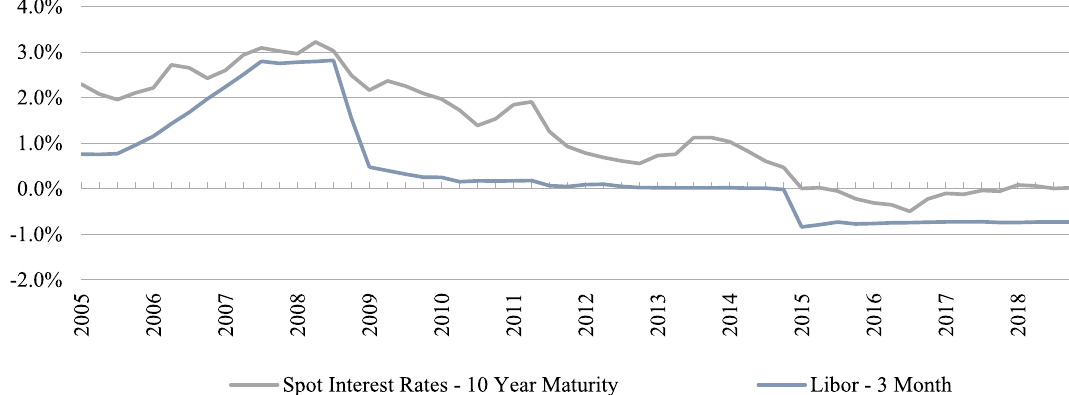
Fig. 2 Spot interest rates and Libor target rates. Spot interest rates with 10-year maturity and 3-month Libor rate have been averaged on a quarterly level. The displayed time frame ranges from 2005 Q1 to 2018 Q4. Source: